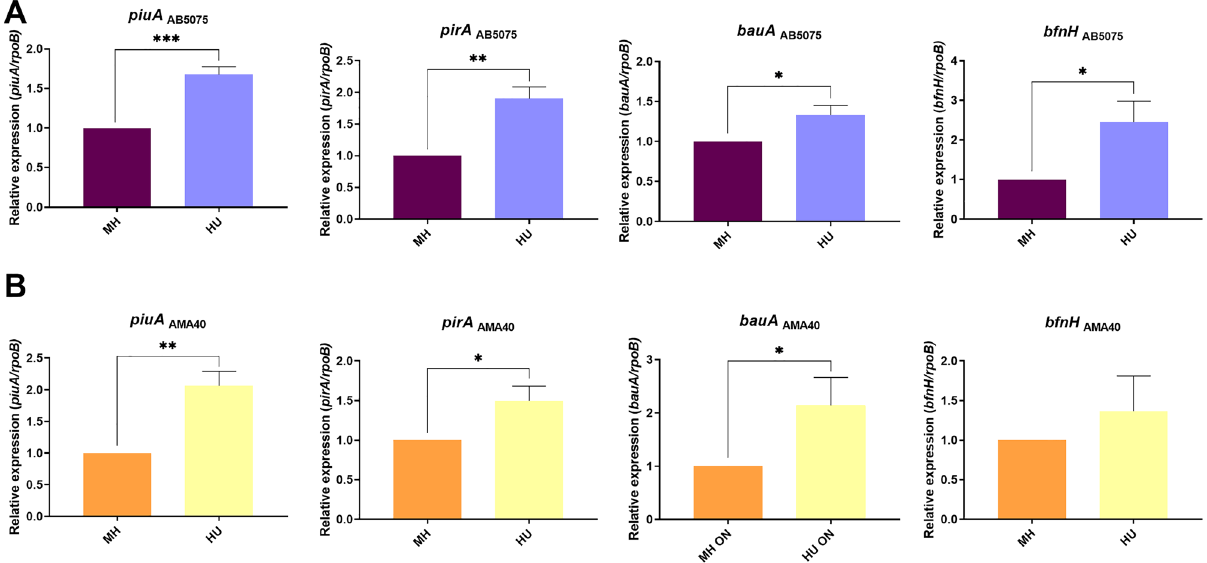
Figure 1. Genetic analysis of iron uptake genes of AB5075 ( A ) and AMA40 ( B ) A. baumannii strains. qRT-PCR of genes associated with iron uptake, pirA, piuA, bauA and bfnH expressed in cation adjusted Mueller Hinton or cation adjusted Mueller Hinton supplemented with 50% HU. Fold changes were calculated using double ΔCt analysis. At least three independent samples were used, and four technical replicates were performed from each sample. The cation adjusted Mueller Hinton was used as reference. Statistical significance ( p < 0.05) was determined by ANOVA followed by Tukey’s multiple-comparison test, one asterisks: p < 0.05; two asterisks: p < 0.01 and three asterisks: p <